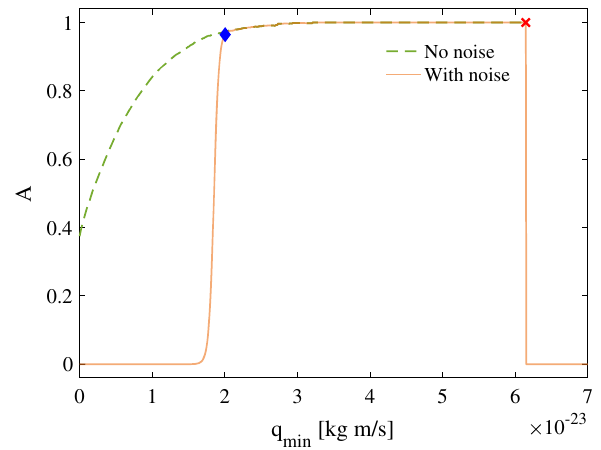
Fig. 3 The dependence of the asymmetry A on a lower bound for the recoil momentum q min for a benchmark point with (solid line) and without noise from residual gas (dashed line). As soon as q min is larger than the maximal DM recoil momentum there are no events left and the lines end at the red cross. The blue diamond corresponds to the blue diamond in Fig. 2. For more explanations, see main